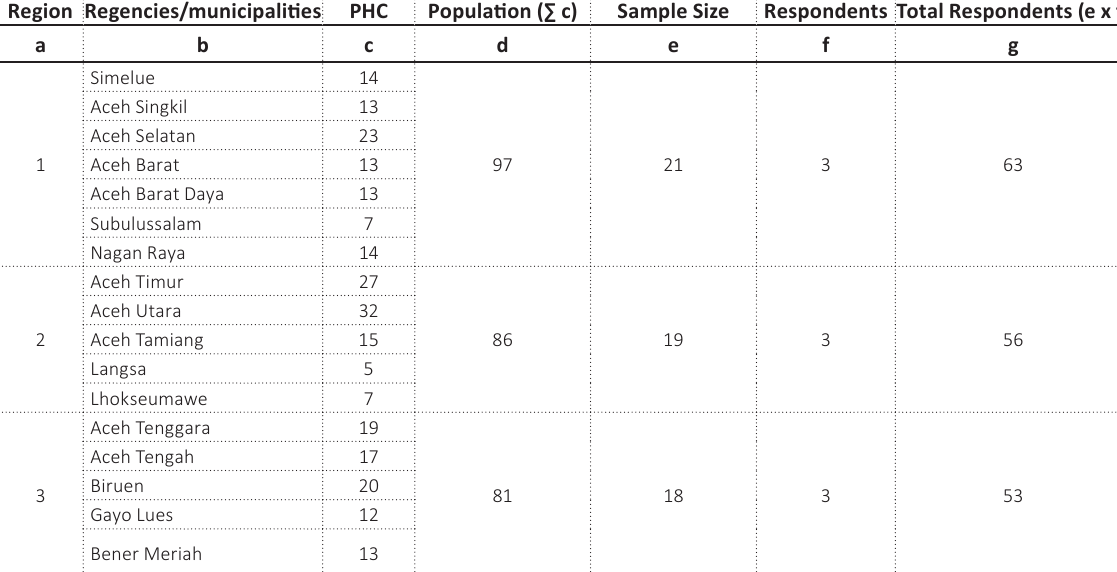
Table 1. Sampling